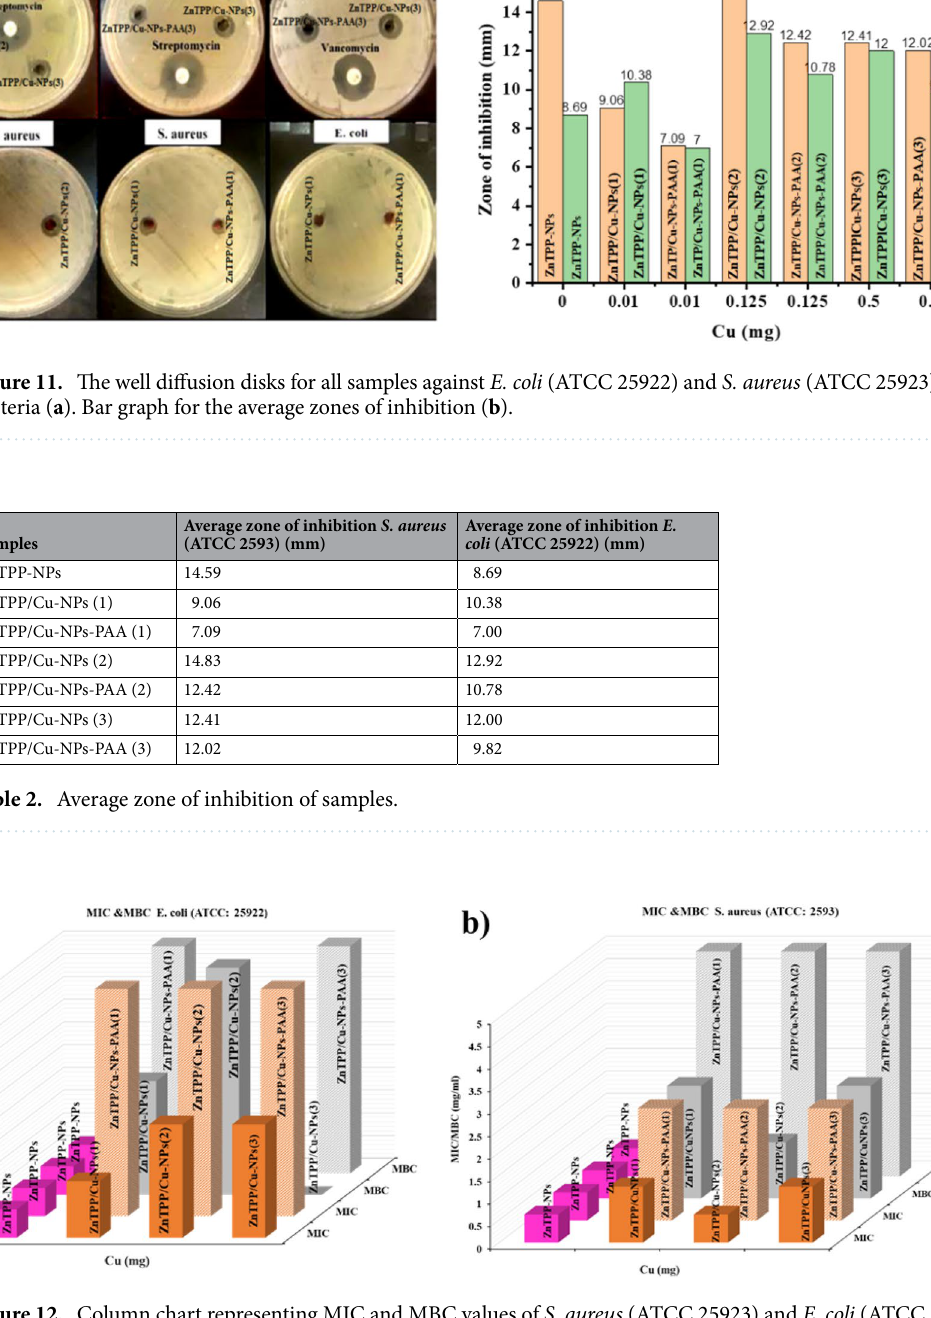
Figure 12. Column chart representing MIC and MBC values of S. aureus (ATCC 25923) and E. coli (ATCC